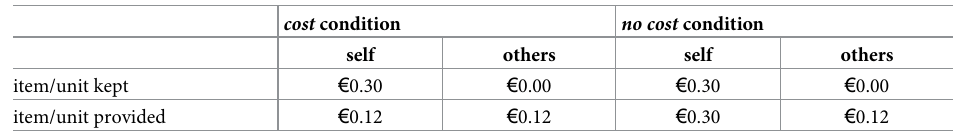
Table 2. Marginal